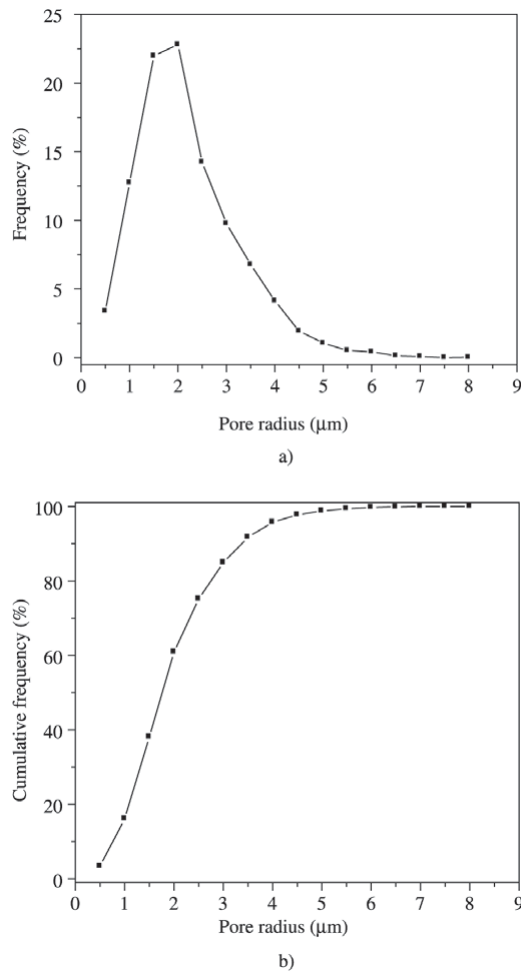
Figure 7. Pore size distribution of sintered stainless steel